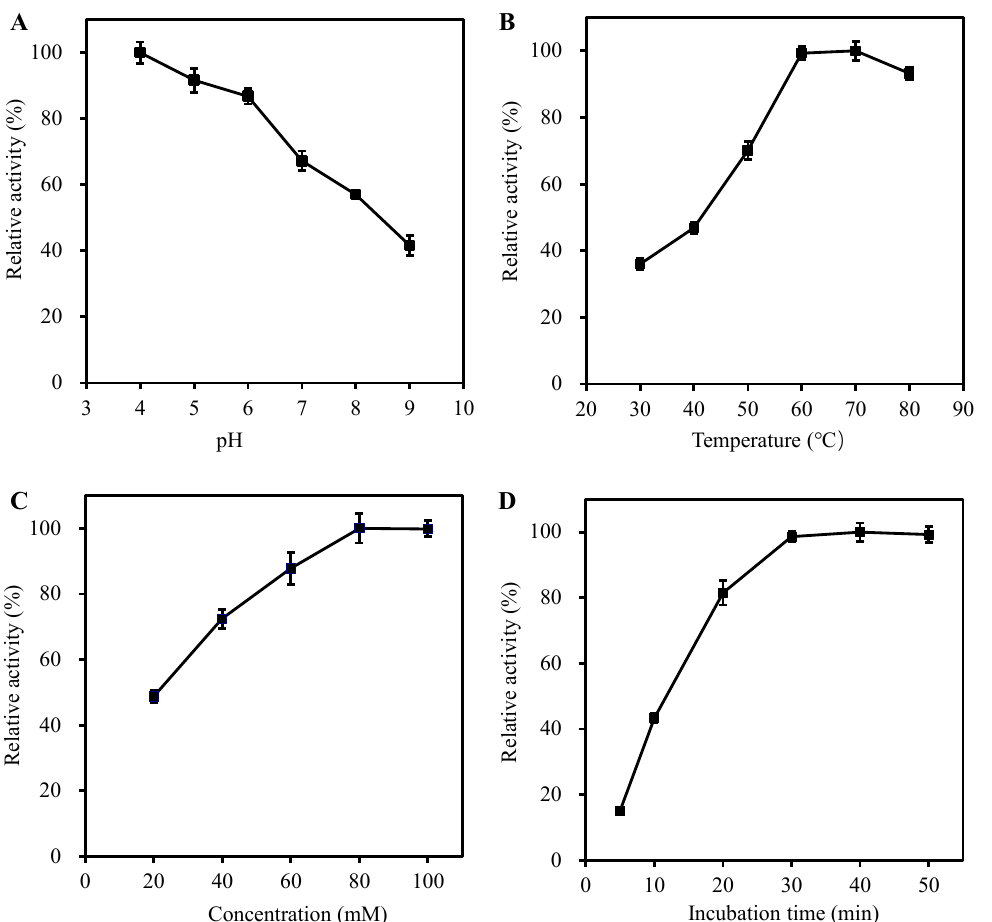
Figure 3. Effects of ( A ) pH, ( B ) temperature, ( C ) VB6 concentration, and ( D ) incubation time on the peroxidase-like activity of VB6. Experiments were carried out using 100 mM of VB6 dissolved in PBS buffer (10 mM, pH = 4.0) at 60 °C with 4.0 mM of TMB and 0.5 mM of H 2 O 2 as substrates. The maximum point in each curve is set as 100%. The error bars represent the standard deviations derived from three independent measurements.